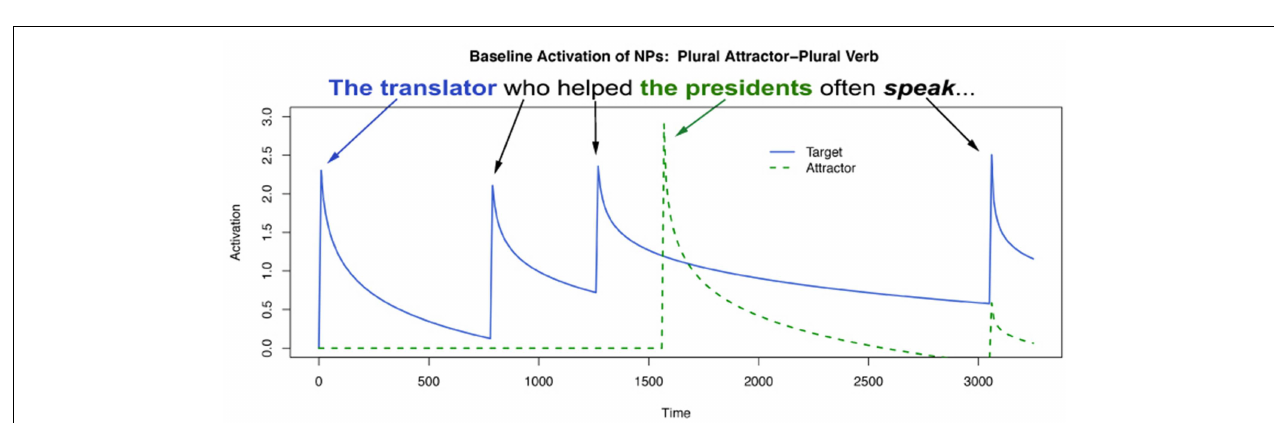
FIGURE 7 | Model activation values over time for an ACT-R model of ungrammatical attraction conditions.